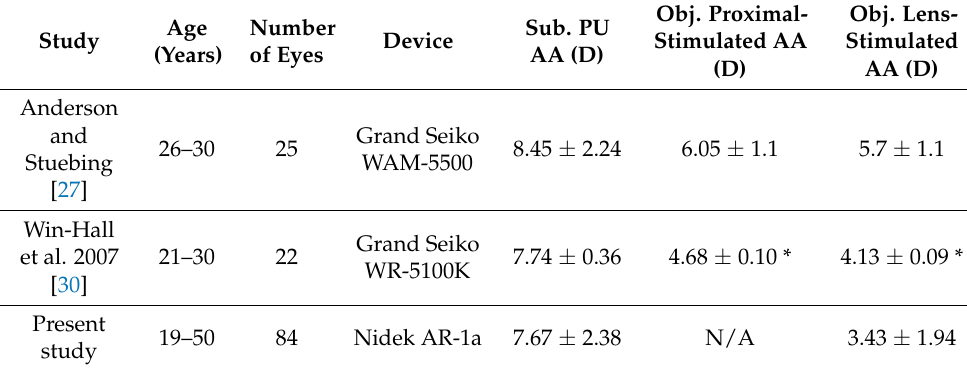
Table 2. Studies comparing the objective amplitude of accommodation obtained with commercially available autorefractors inducing 5 D accommodative stimulation using lens or proximity stimulus with subjective